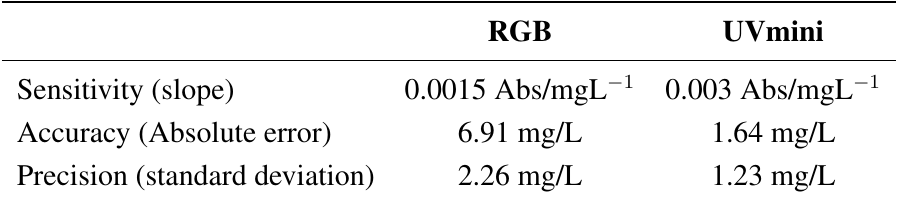
Table 1. Features of the proposed RGB sensor and the UVmini